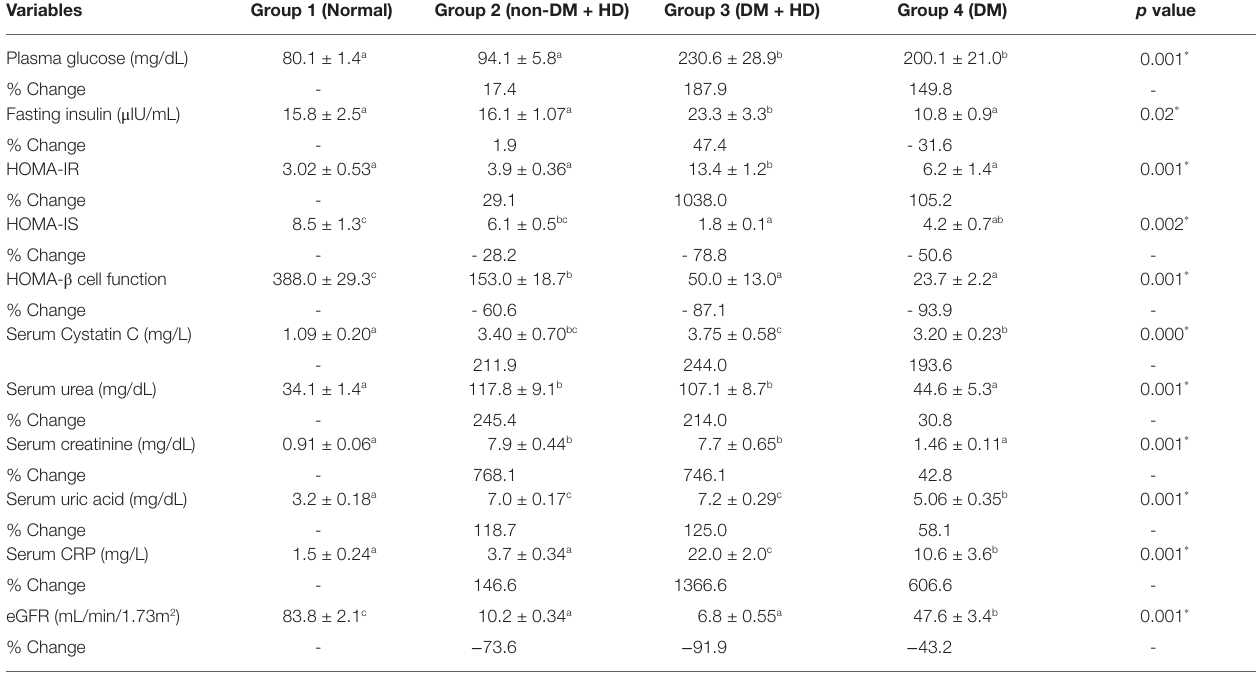
Data are expressed as mean ± SE. For each variable, values, which have different superscript letters, are significantly different at p < 0.05.